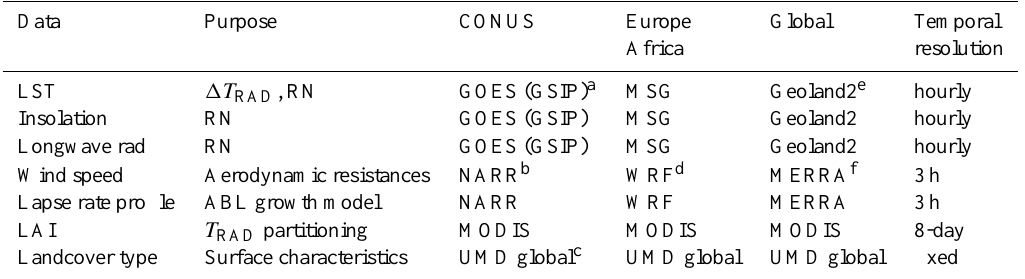
Table 2. Primary inputs required by ALEXI, data sources used over the CONUS, Europe/Africa domains, and proposed sources for a global